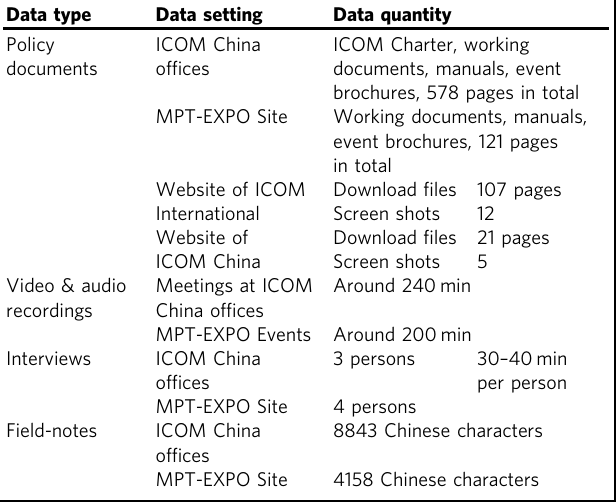
Table 3 Ethnographic data